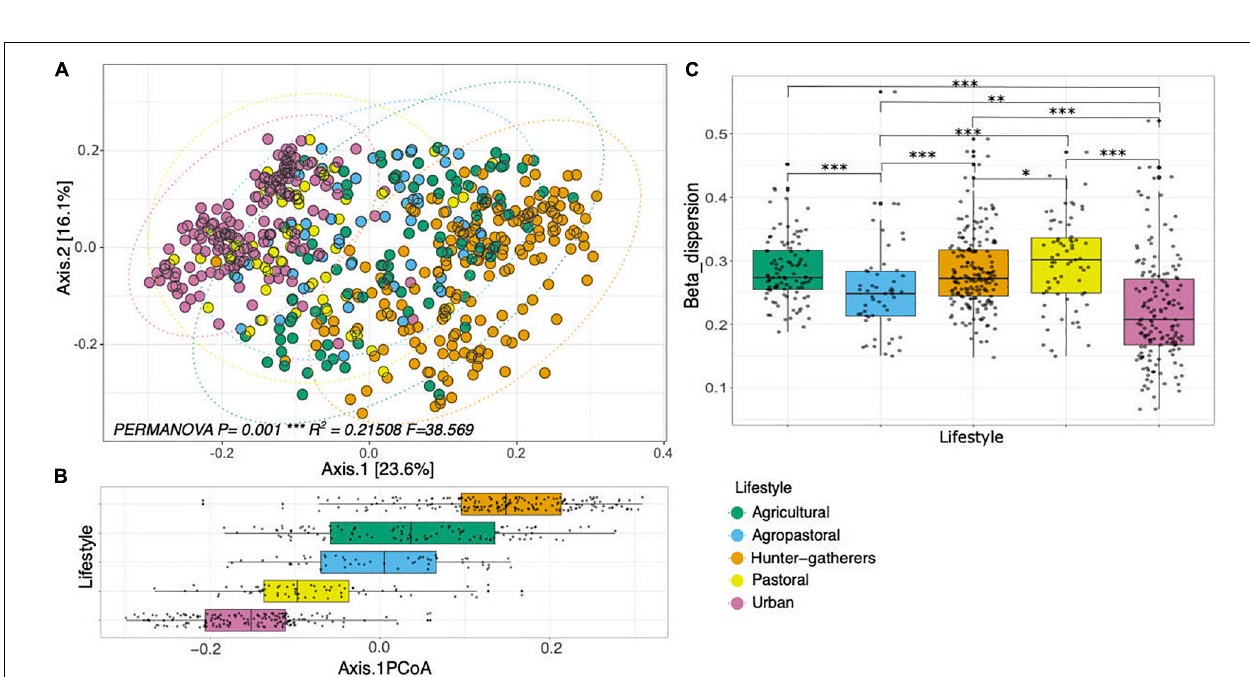
FIGURE 2 | Beta diversity analysis of human gut microbiome between lifestyles. (A) Principal Coordinates Analysis (PCoA) with unweighted UniFrac distance at the family level. (B) Boxplots of the distribution of each lifestyle across axis 1 of the PCoA. (C) Boxplot of the Multivariate Beta Dispersion analysis comparison of different lifestyles. Asterisks denote statistical significant differences given by Wilcoxon rank-sum test ( ∗ p < 0.05, ∗∗ p < 0.01, ∗∗∗ p < 0.001, ∗∗∗∗ p < 0.0001).